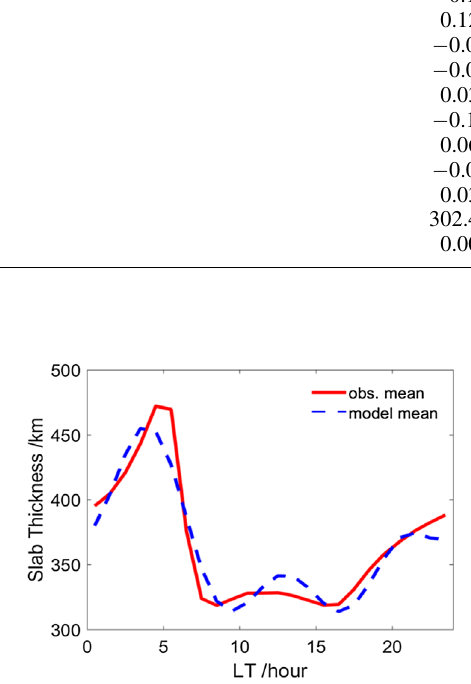
Fig. 3. Overall variation of the equivalent slab thickness as a function of the season (red line) in comparison with model values (blue